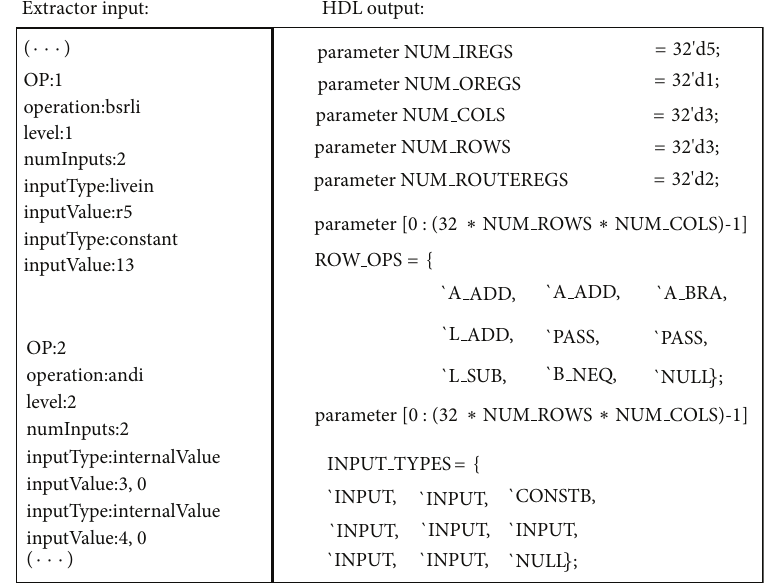
F 12: RPU HDL header